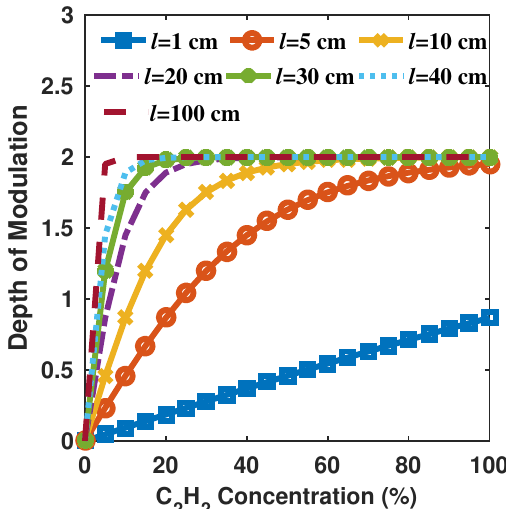
Figure 3. Depth of modulation as a function of concentration considering different cell path length